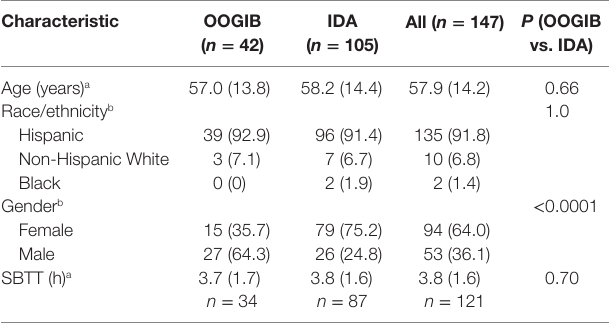
TaBle 1 | characteristics of 147 patients with overt obscure gastrointestinal (gi) bleeding (OOgiB) or iron deficiency anemia/occult obscure gi bleeding (iDa) who underwent video capsule